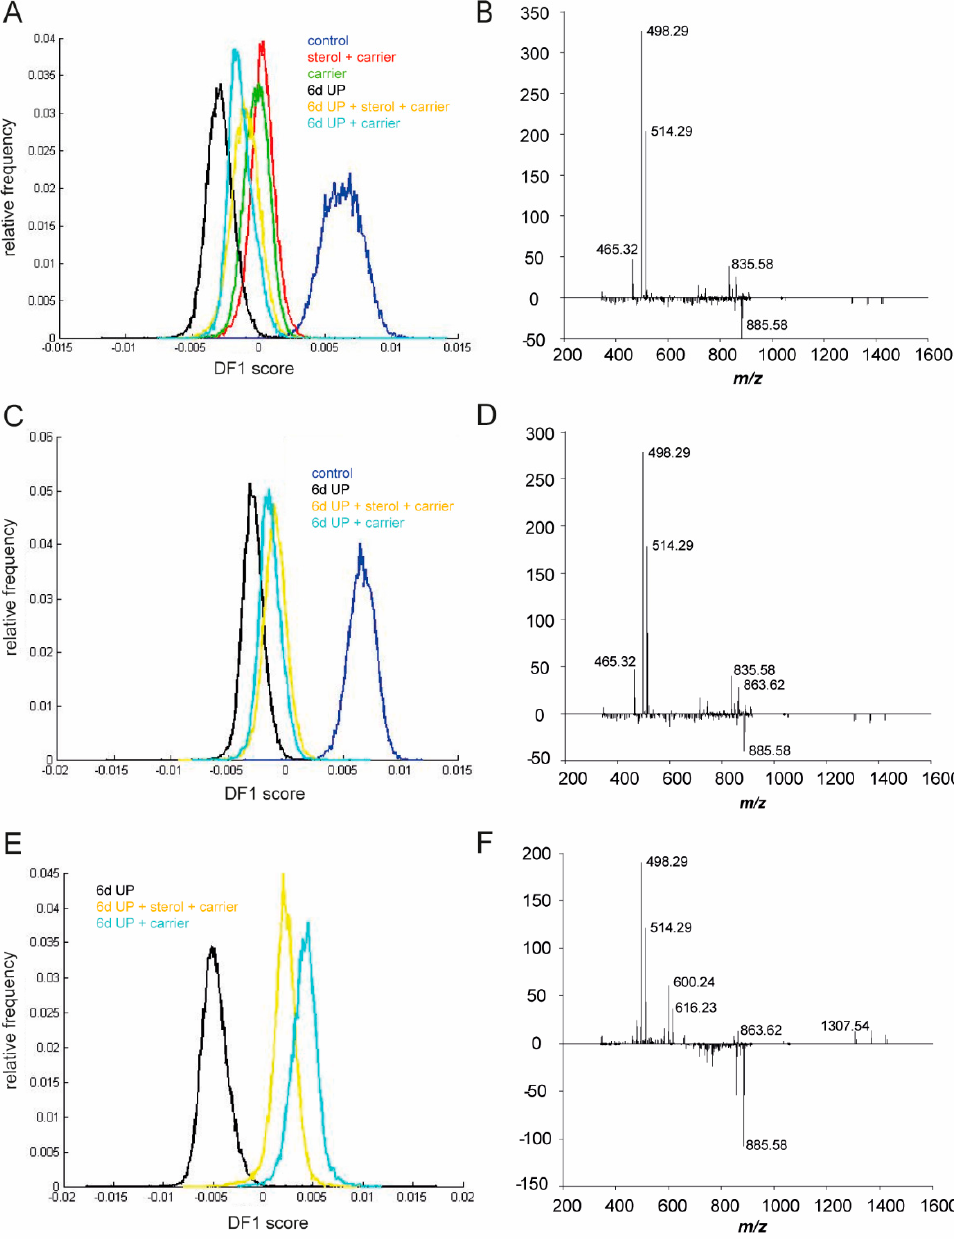
Figure 11. Matrix-assisted laser desorption ionization mass spectrometry imaging performed in negative ion mode followed by principal component analysis. The first discriminant function is shown. ( A ) 6-d UP group animals showed an altered lipid profile compared to the other treatment groups, ( B ) with a higher abundance of m/z 885.58 PI 38:4 [M-H]- and a reduced presence of m/z 498.29